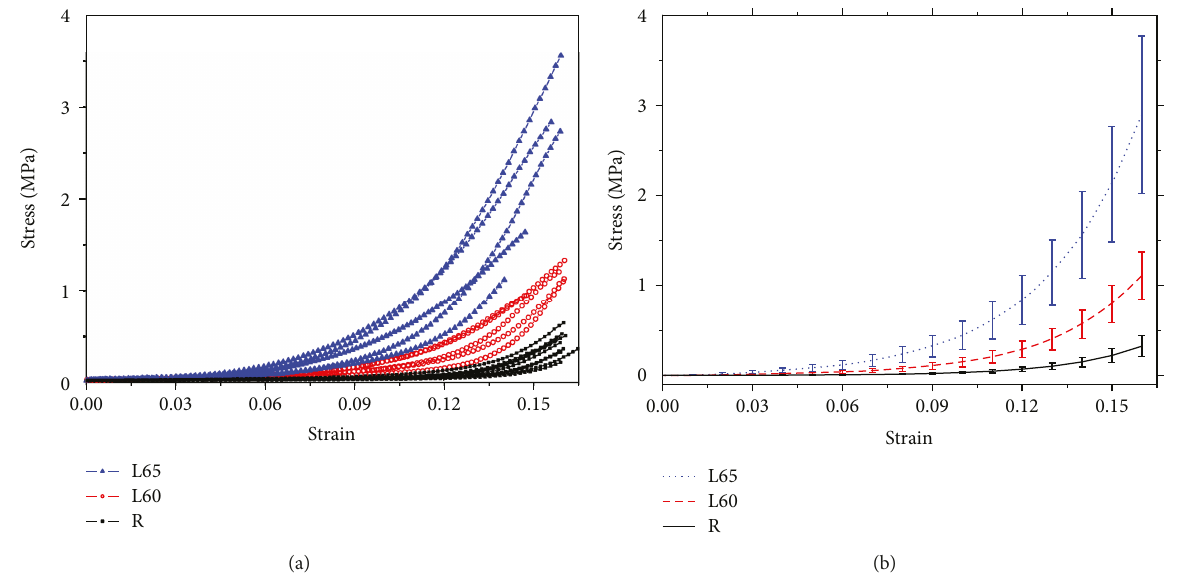
Figure 7: Stress-strain data (a) and its theoretical fi t (b) of corneal strips. Table 3: The fi tted parameters of stress-strain data.